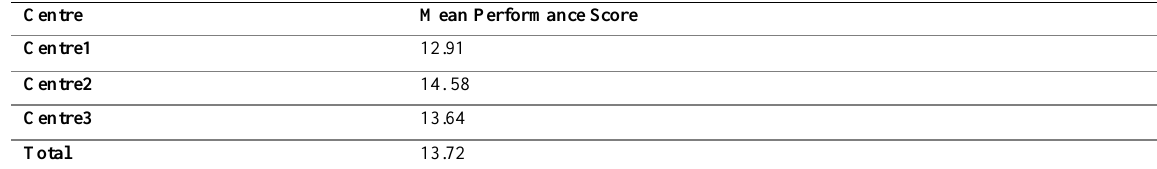
Table 4: Mean Performance Score of the